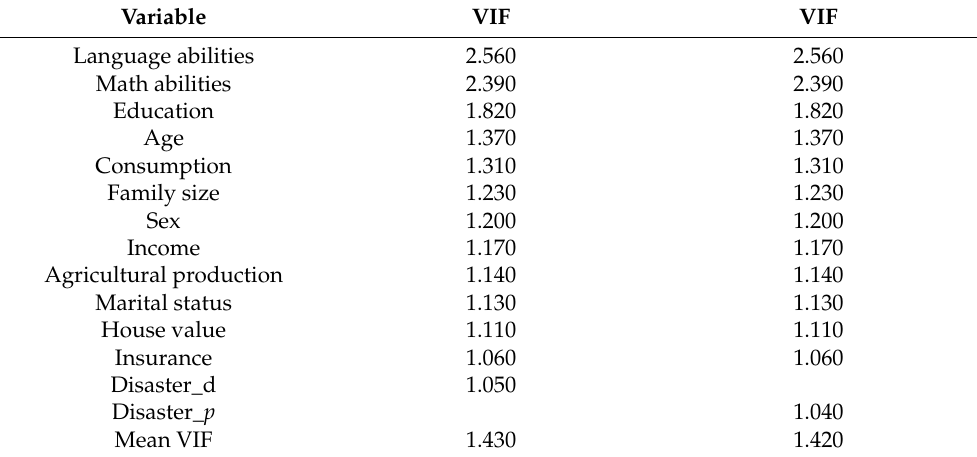
Table 2. The variance inflation factor of each variable.